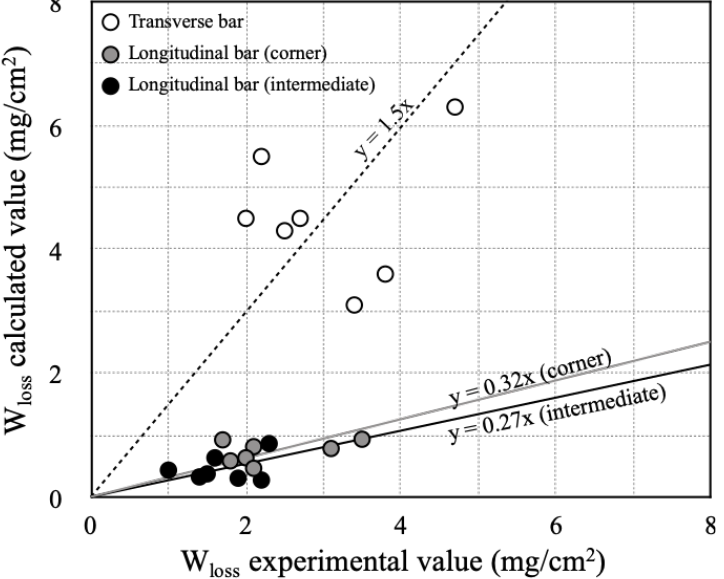
Figure 4. Comparison of calculated and experimentally determined rebar weight loss.